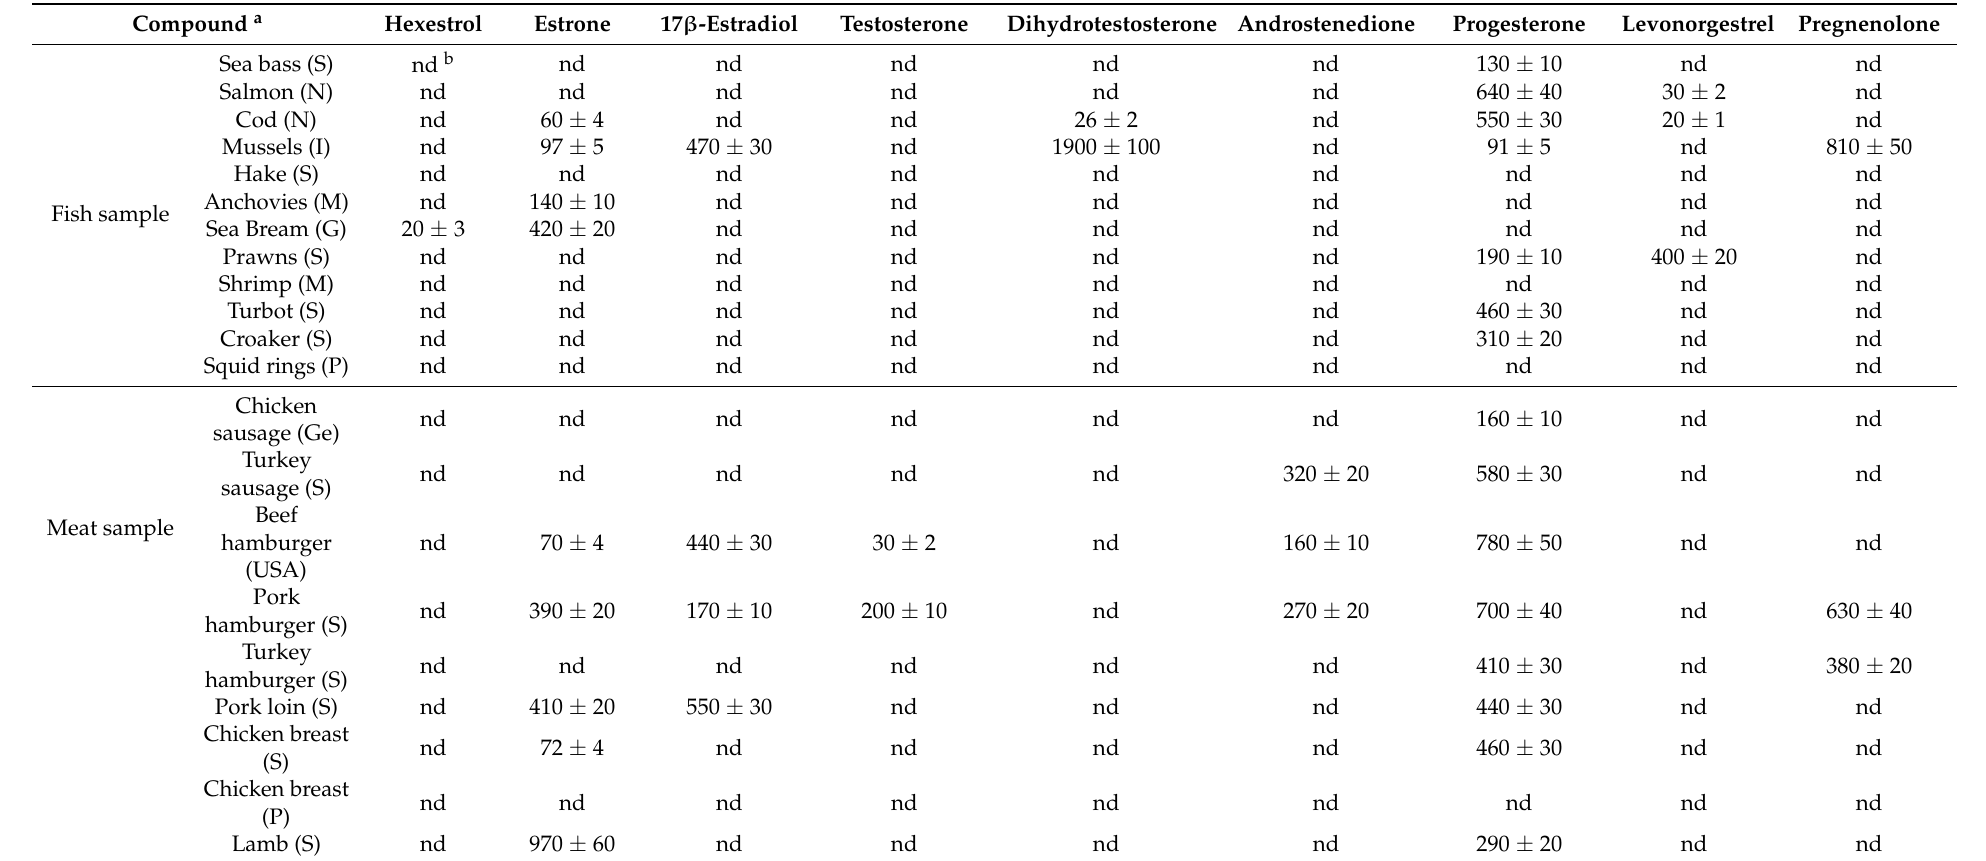
Table 3. Determination of natural and synthetic hormones in meat and fish samples from various markets around the world (mean values ± standard deviation, ng/kg, n =